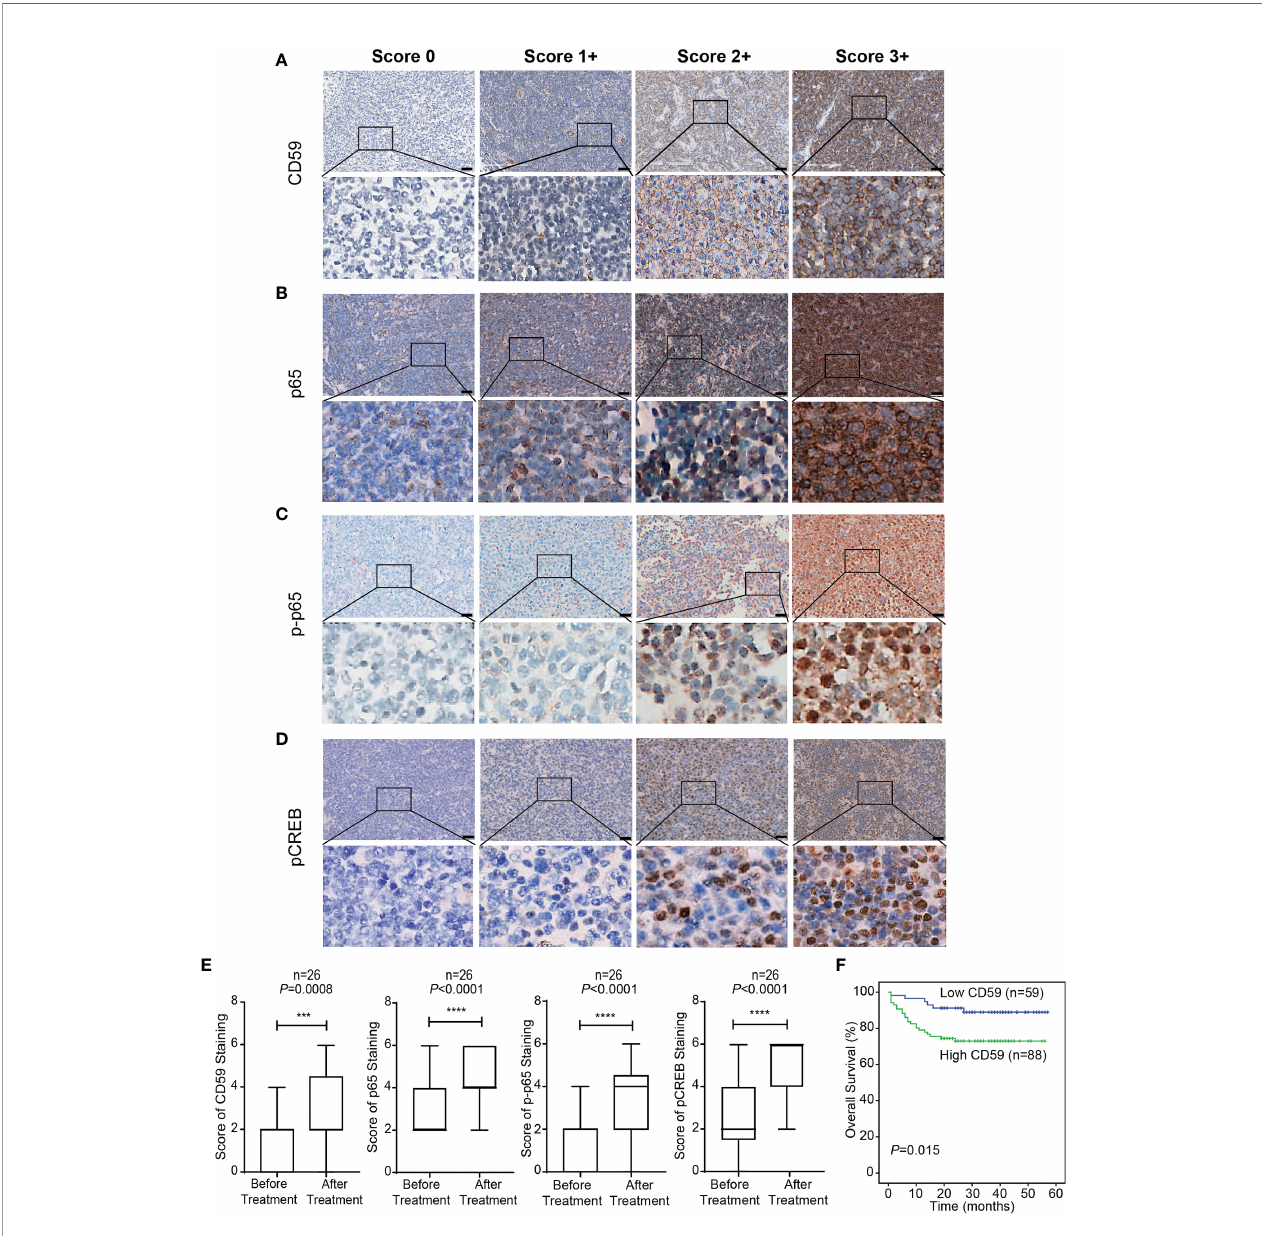
FIGURE 1 | The expression level of CD59 in tumor tissues of DLBCL patients with R-CHOP treatment. (A – D) The representative Immunohistochemistry (IHC) images of CD59 (A) , NF- k B (p65) (B) , phosphorylated p65 (p-p65) (C) and phosphorylated CREB (D) staining. CD59 protein is mainly expressed in the cell membrane. NF- k B (p65) proteins is mainly expressed in the cytoplasm and nucleus. Phosphorylated p65 protein is mainly expressed in the nucleus. Phosphorylated CREB is mainly nuclear-localized. First column: score 0; Second column: 1+; Third column: 2+; Forth column: 3+; scale bar is 50 m m. (E) The expression of CD59 and NF- k B (p65), and the phosphorylation of p65 and CREB elevated signi fi cantly after R-CHOP treatment compared to the paired naïve DLBCL tissues. Values represent mean ± SD, n = 26. *** P < 0.001, **** P < 0.0001 vs before treatment, as analyzed by paired two-tailed Student ’ s t test. (F) IHC was used to detect the expression levels of CD59 in tumor tissues of 147 DLBCL patients. The Kaplan-Meier survival curve indicates that the high CD59 expression group has a shorter survival rate than the low CD59 expression group ( c 2 = 5.875, P =0.015). A score of 0 to 3 was considered low CD59 expression, and a score of 4 to 6 was considered high CD59